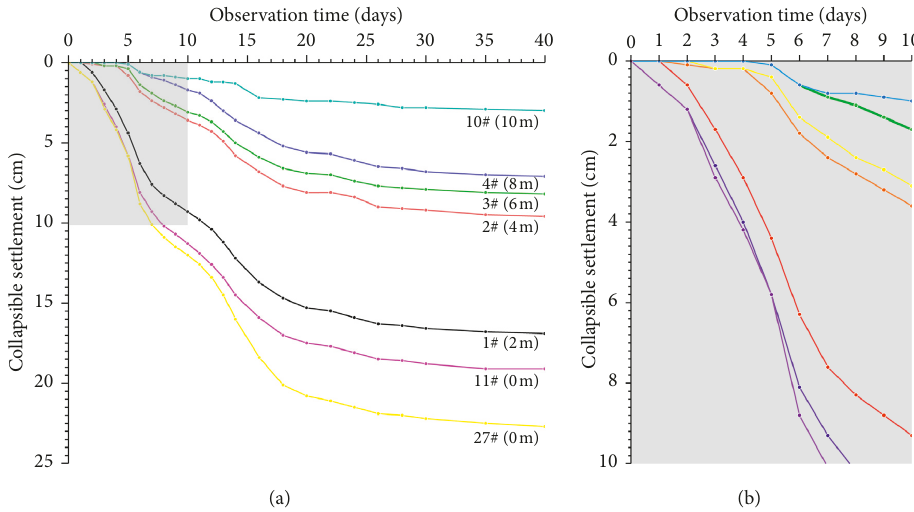
Figure 6: (a) The collapsibility process curve of typical benchmarks in the test pit. (b) Enlarged view of the previous 10 days’ observation